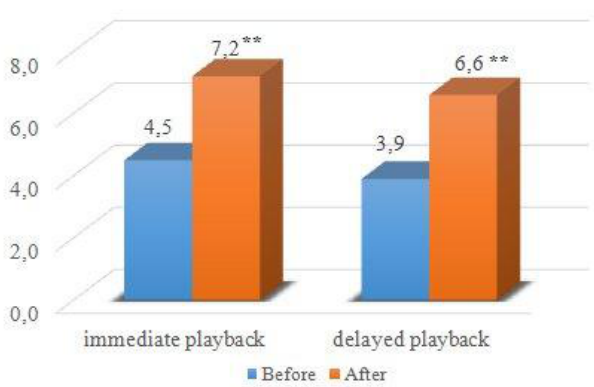
Figure 4: Comparison before and after cognitive test scores. Paired p-test, ** significant at 1%